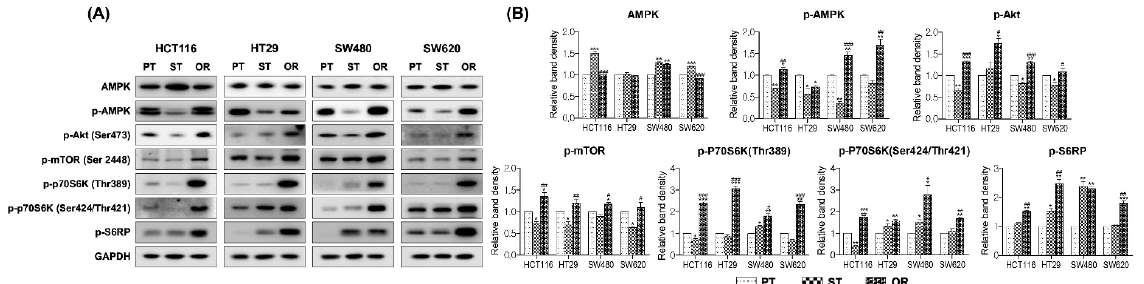
Figure 5. Effect of oxaliplatin resistance on AMPK and Akt/mTOR signaling pathway in the parental (PT), 2.5 µM oxaliplatin single treated PT for 24 h (ST) and oxaliplatin-resistant (OR) colorectal cancer (CRC) cells of HCT116, HT29, SW480 and SW620. ( A ) Protein expression was determined by immunoblot analysis. ( B ) Graphical analysis of band intensities normalized for protein loading with GAPDH. Columns and error bars represent means ± standards deviation of immunoblot band intensities of 3 separate protein preparations. The * statistics showed the comparison with PT and the # statistics showed the comparison between ST and OR. * or # , p < 0.05; ** or ## , p < 0.01; *** or ### , p < 0.001. p-, phospho-; GAPDH, glyceraldehyde 3-phosphate dehydrogenase.